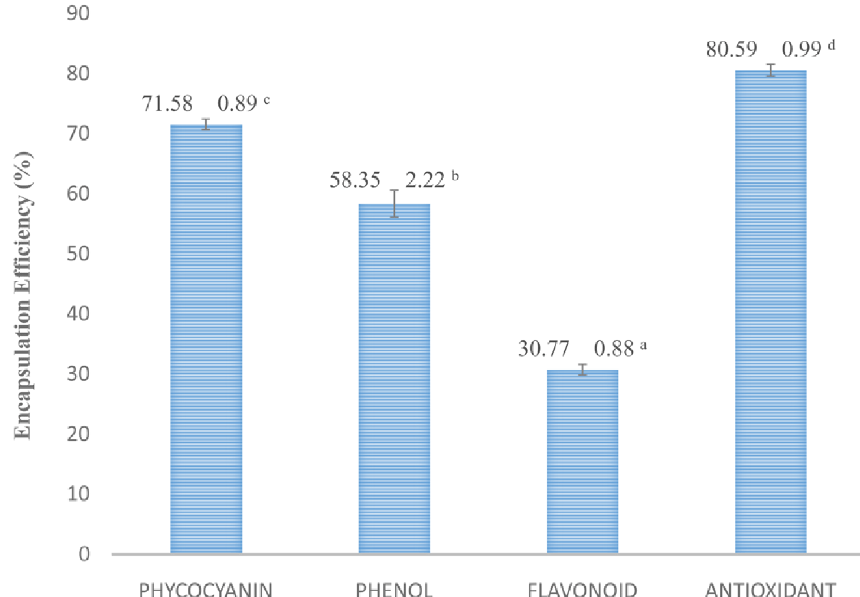
Figure 4. Encapsulation efficiency. (n=3, mean value ± standard deviation; different superscripts indicate a significant